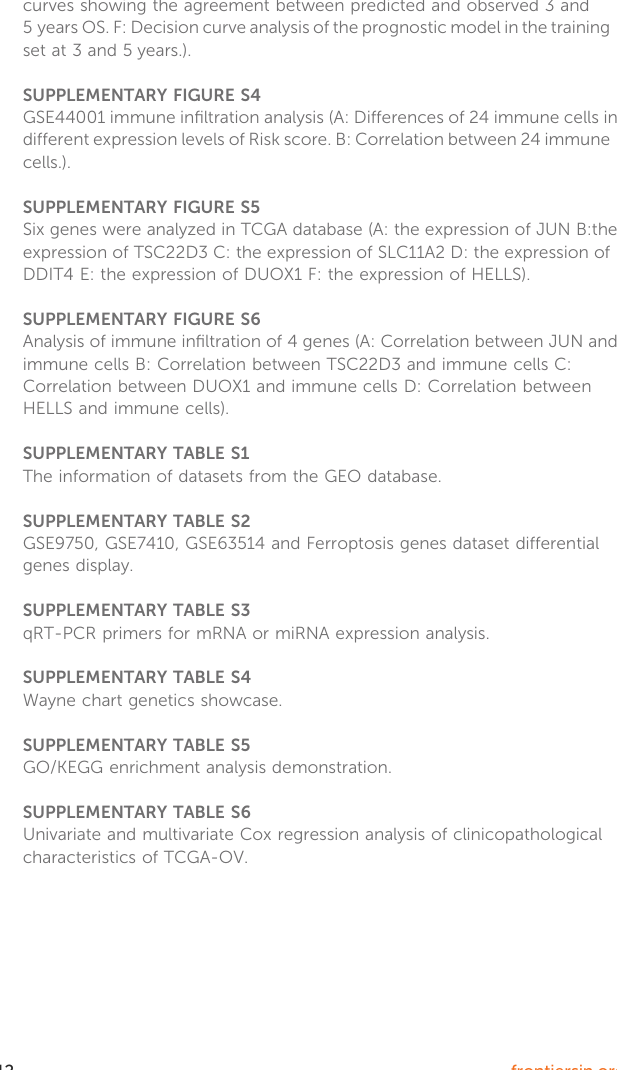
SUPPLEMENTARY TABLE S4 Wayne chart genetics showcase. SUPPLEMENTARY TABLE S5 GO/KEGG enrichment analysis demonstration. SUPPLEMENTARY TABLE S6 Univariate and multivariate Cox regression analysis of clinicopathological characteristics of